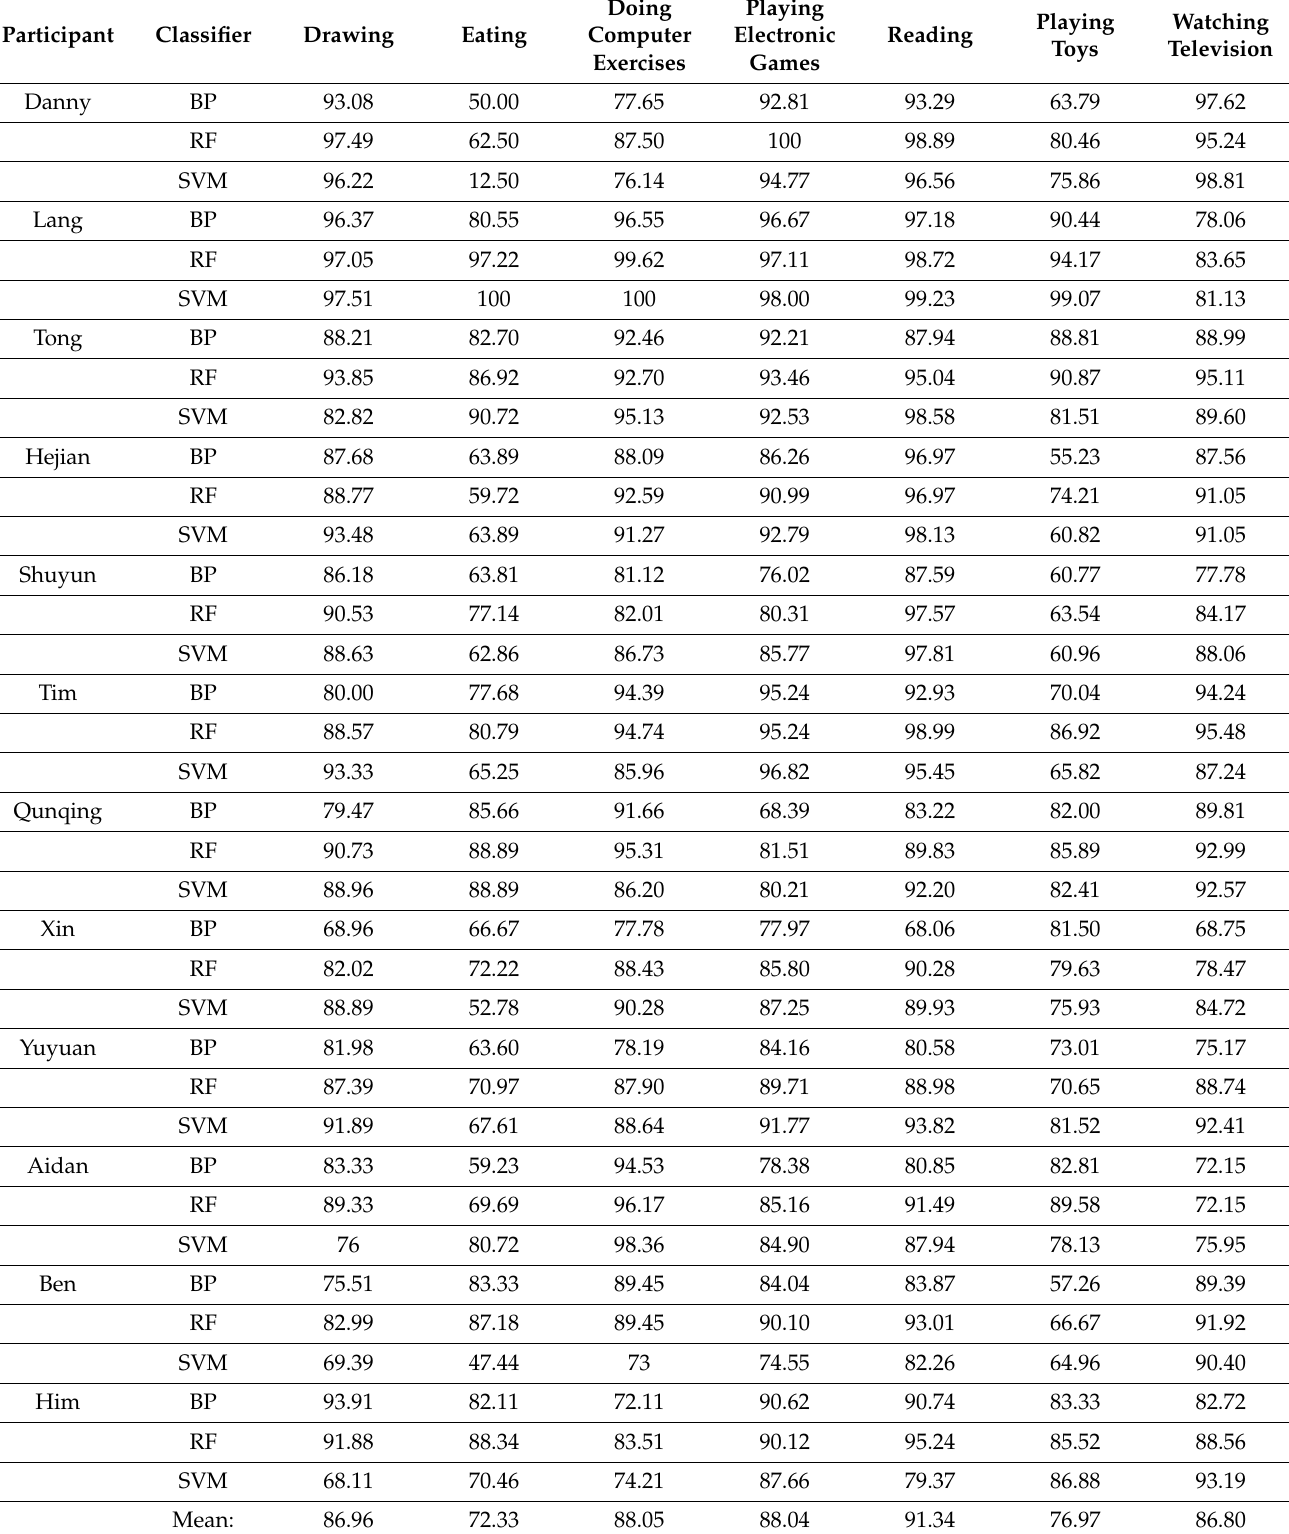
Table 8. The percentages of the classification accuracies for 12 participants performing the various activities under the immersion state via yielded by our